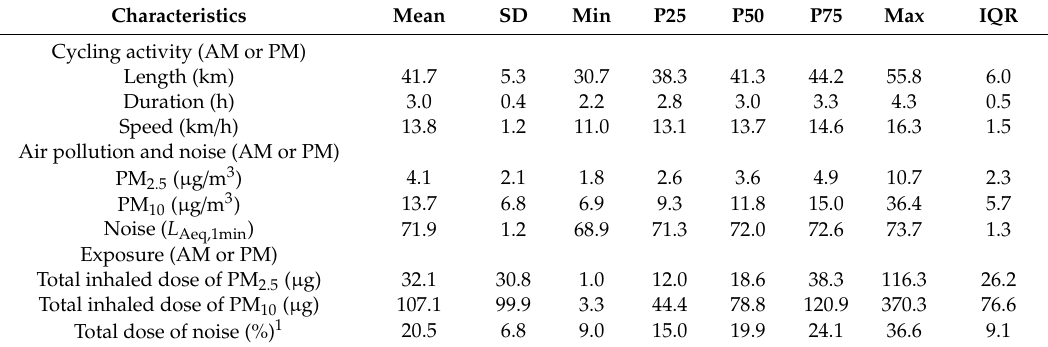
Table 2. Descriptive statistics of air / noise pollution exposure and inhaled doses while cycling. Characteristics Mean SD Min P25 P50 P75 Max IQR Cycling activity (AM or PM) Length (km) 41.7 Duration (h) Air pollution and noise (AM or PM) PM 10 ( µ g / m 3 ) Exposure (AM or PM) Total inhaled dose of PM 2.5 ( µ g) Total inhaled dose of PM 10 ( µ g) 107.1